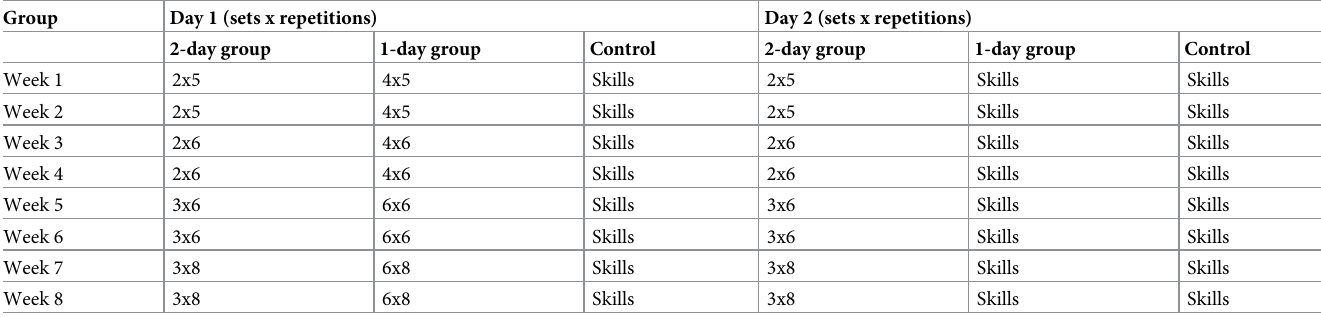
Table 1. Training load during the 2-day, 1-day and control group.